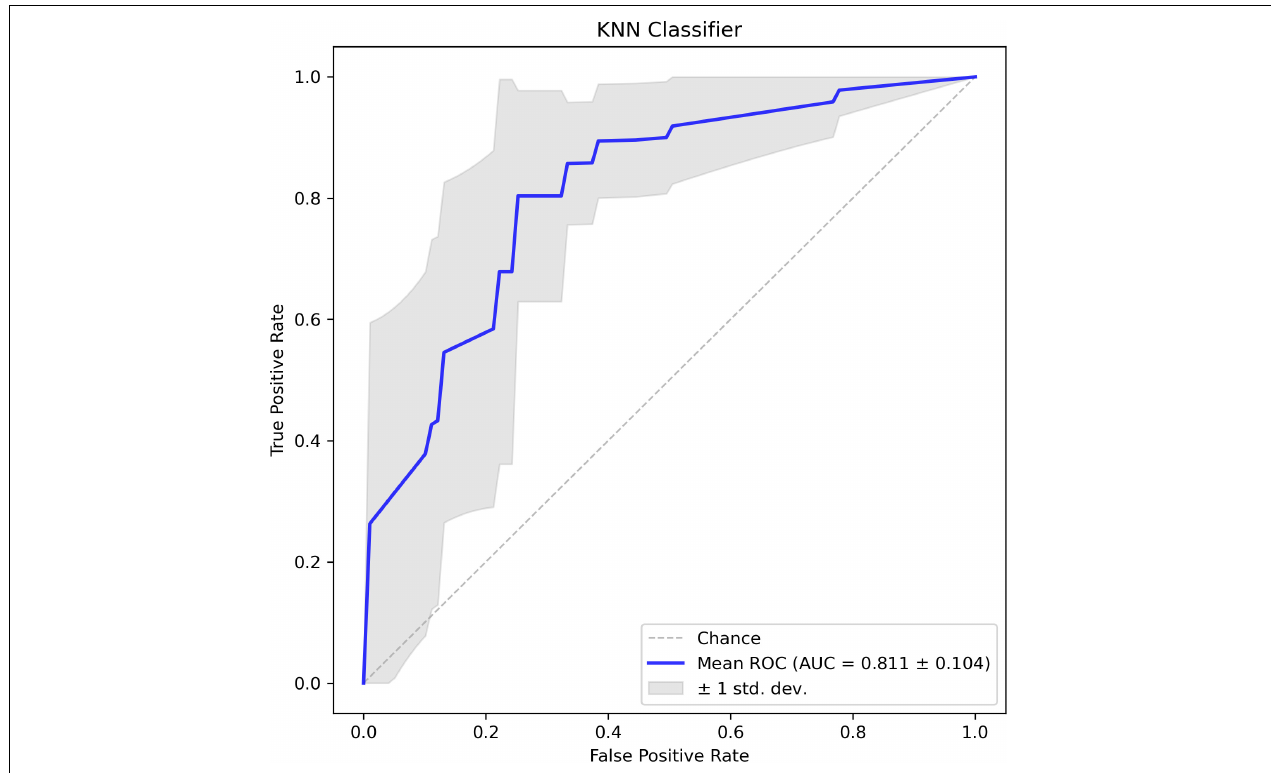
FIGURE 6 | The mean receiver operating characteristic (ROC) curve of the k -nearest neighbor (KNN) classifier based on 8-fold cross-validation.